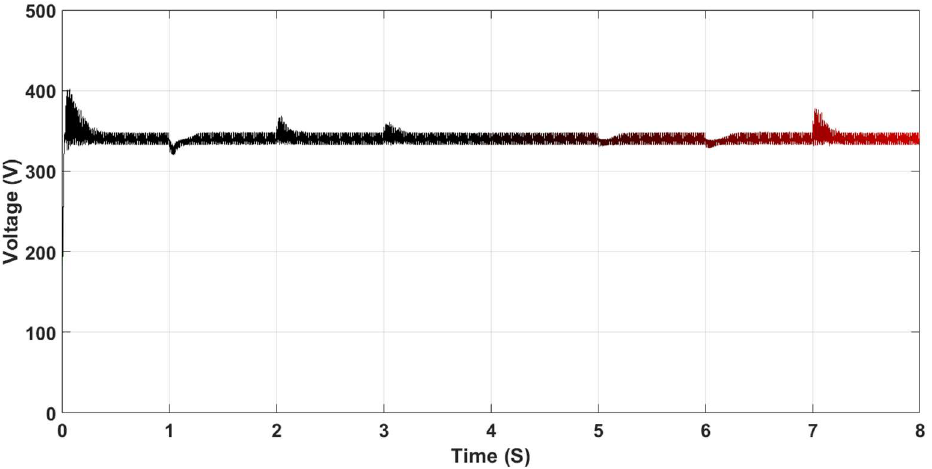
Figure 19. PV output power.